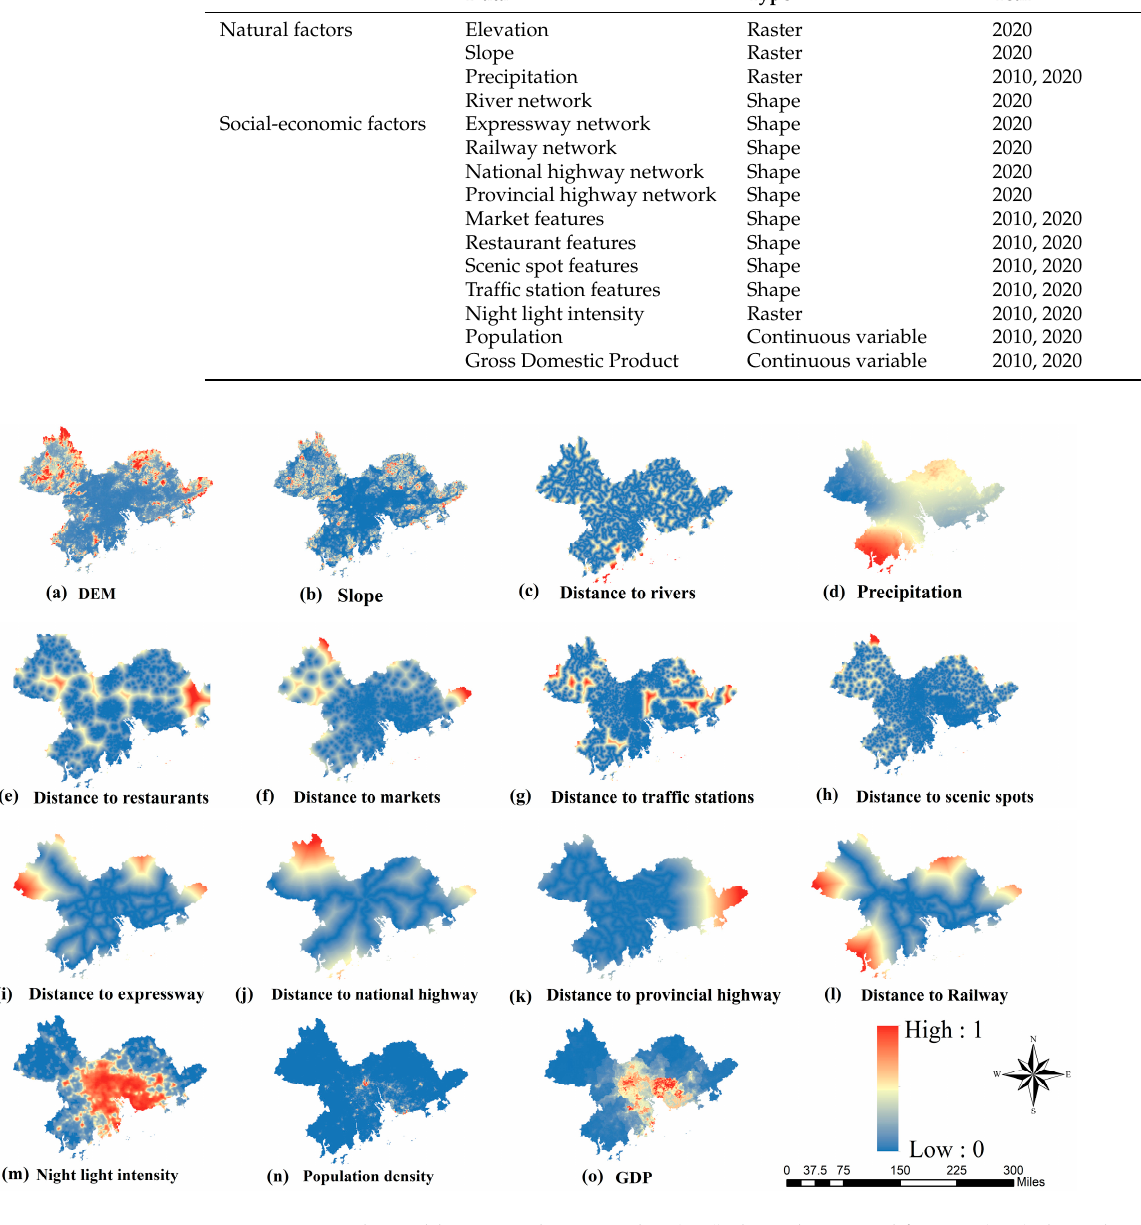
Table 1. Data used in the study.